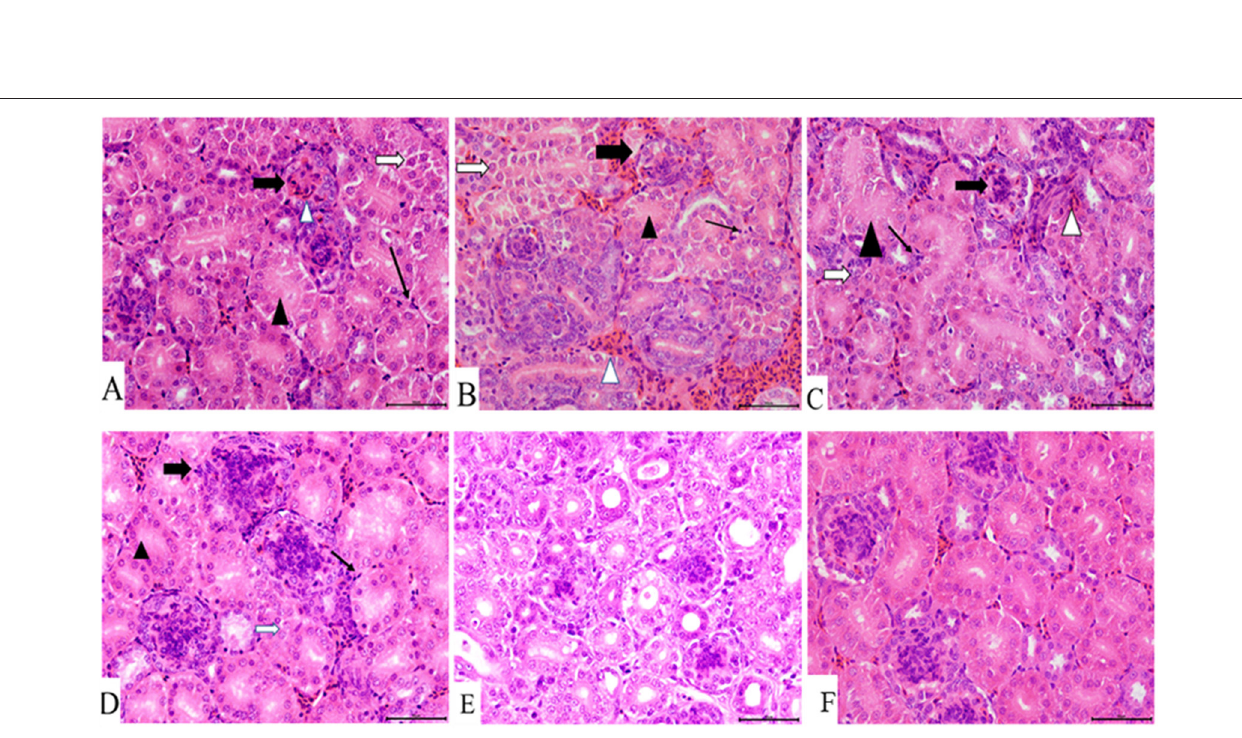
Frontiers in Veterinary Science |